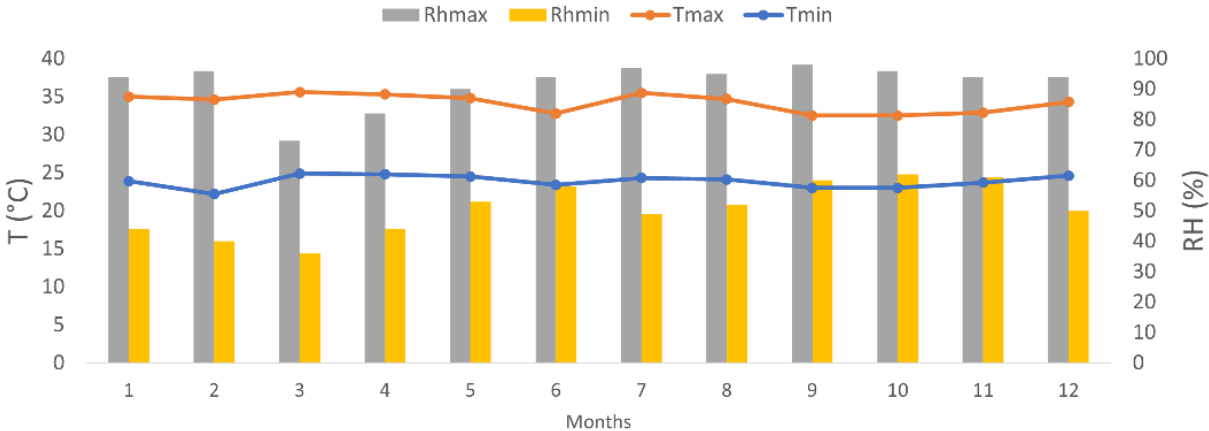
Figure 4. Average wind speed and direction for each month of the year. A photovoltaic generation system is considered, the panel model was chosen based on market availability in the region and the main technical specifications are listed below: (1) Active area: 1.68 m 2 , (2) Nominal Maximum Power: 320 W, (3) Number of cells: 72, (4) Cell type: Polycrystalline Silicon and (5) Panel efficiency: 15%. These and the other elec- trical specifications required for the simulation were configured in the Designbuilder.